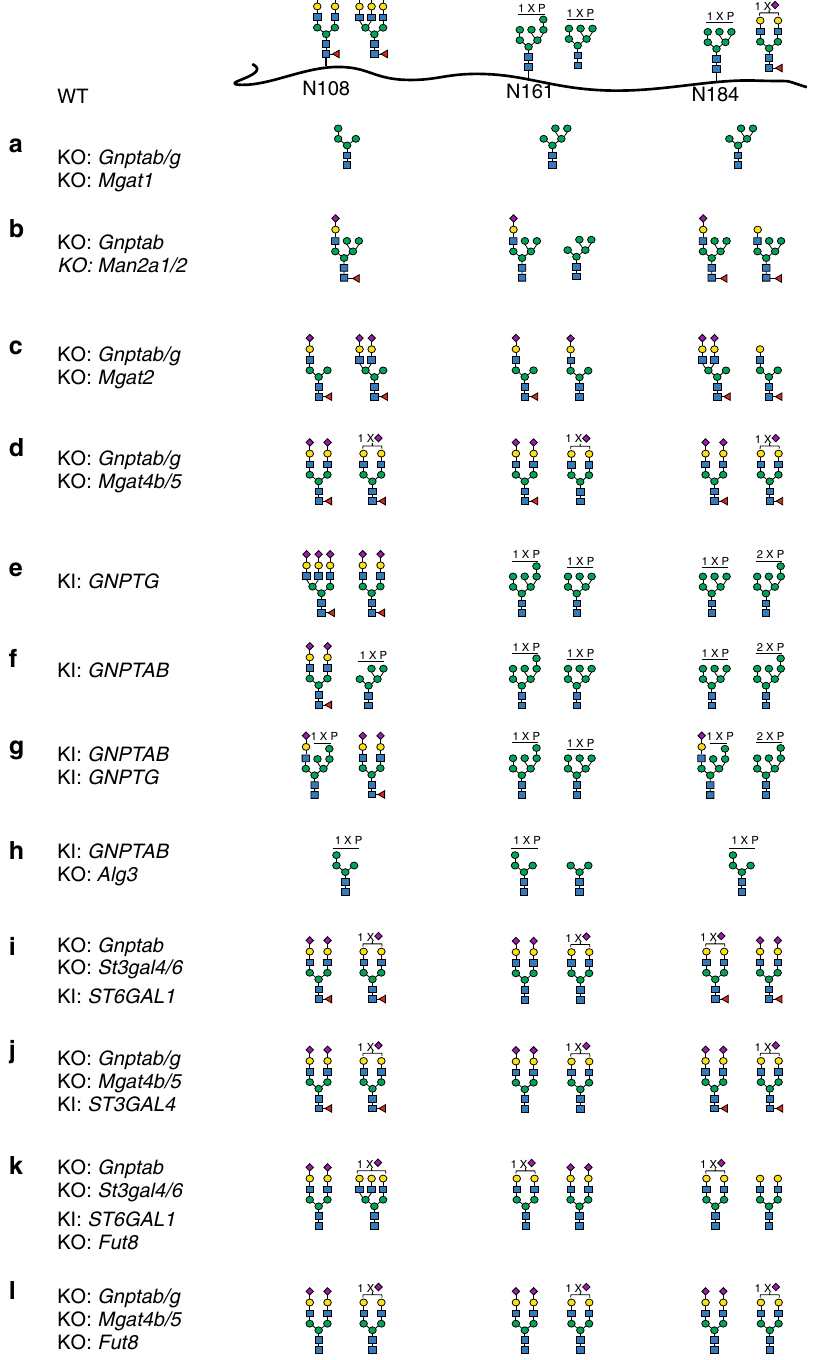
(Fig. 5c, e, f). GLA-Bi23SA with homogeneous bi-antennary N-glycans capped with α 2-3SA (Fig. 5a) exhibited a markedly extended (3-fold) circulation time (half-life 27.5 ± 0.8 min) (Fig. 5c) and lower enzyme activity in the liver, spleen, and